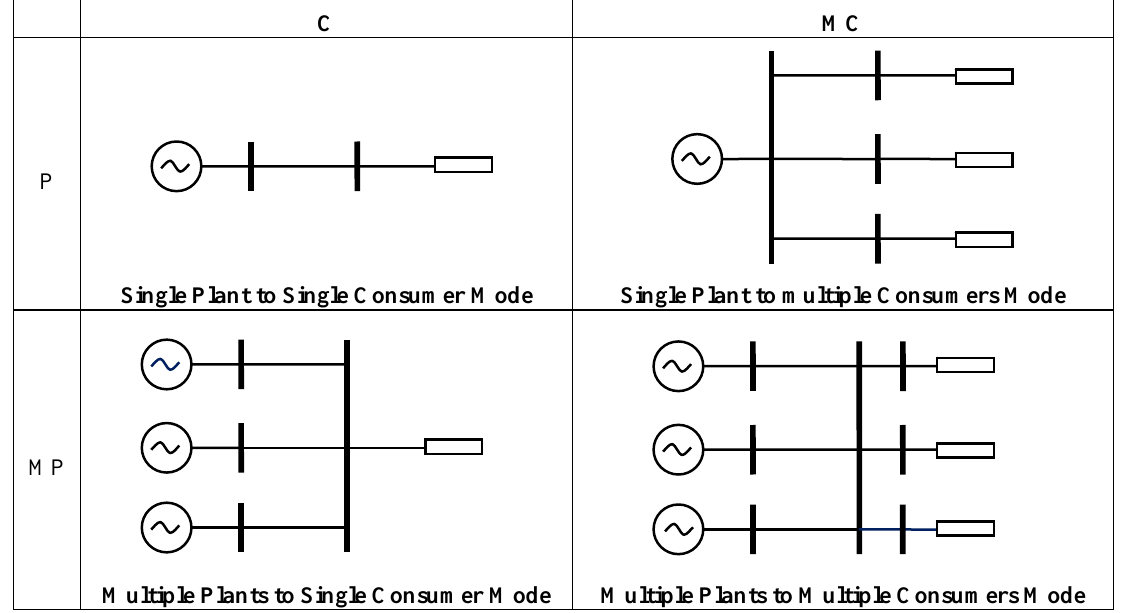
Table 1. Four basic transmission modes in current